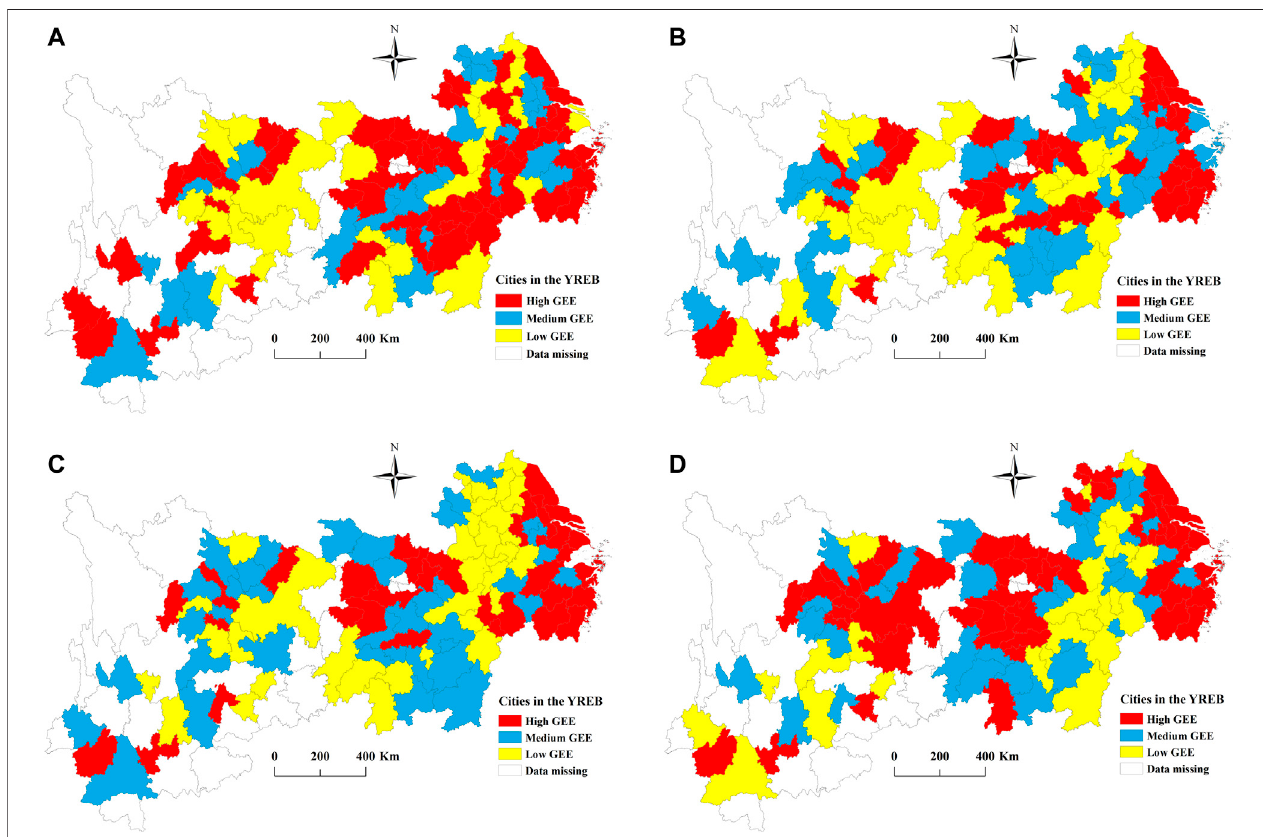
FIGURE3| Distributionoflow(yellow), medium(blue),andhigh(red) gradesofGEE intheYangtzeRiverEconomicBelt. ItismadebyArcgis10.6and shownin (A) 2003, (B) 2008, (C) 2013, and (D) 2018, respectively.